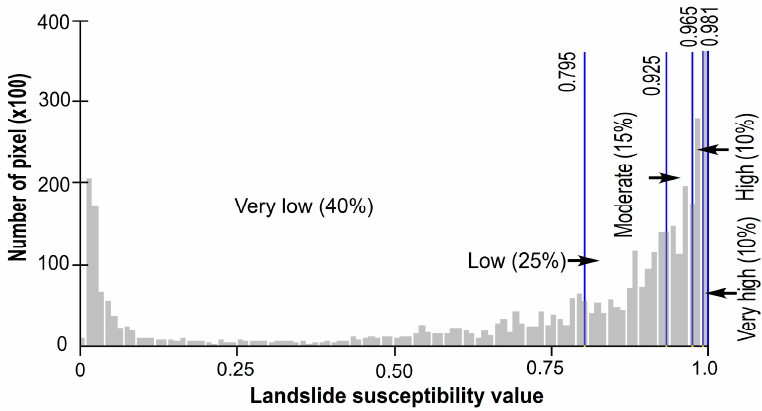
Figure 11. Distribution of these susceptibility indices versus of the five susceptibility classes.